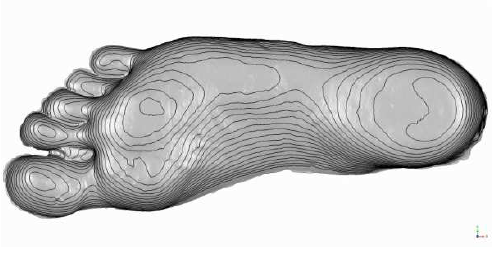
Figure 3. Contour lines of the imprint